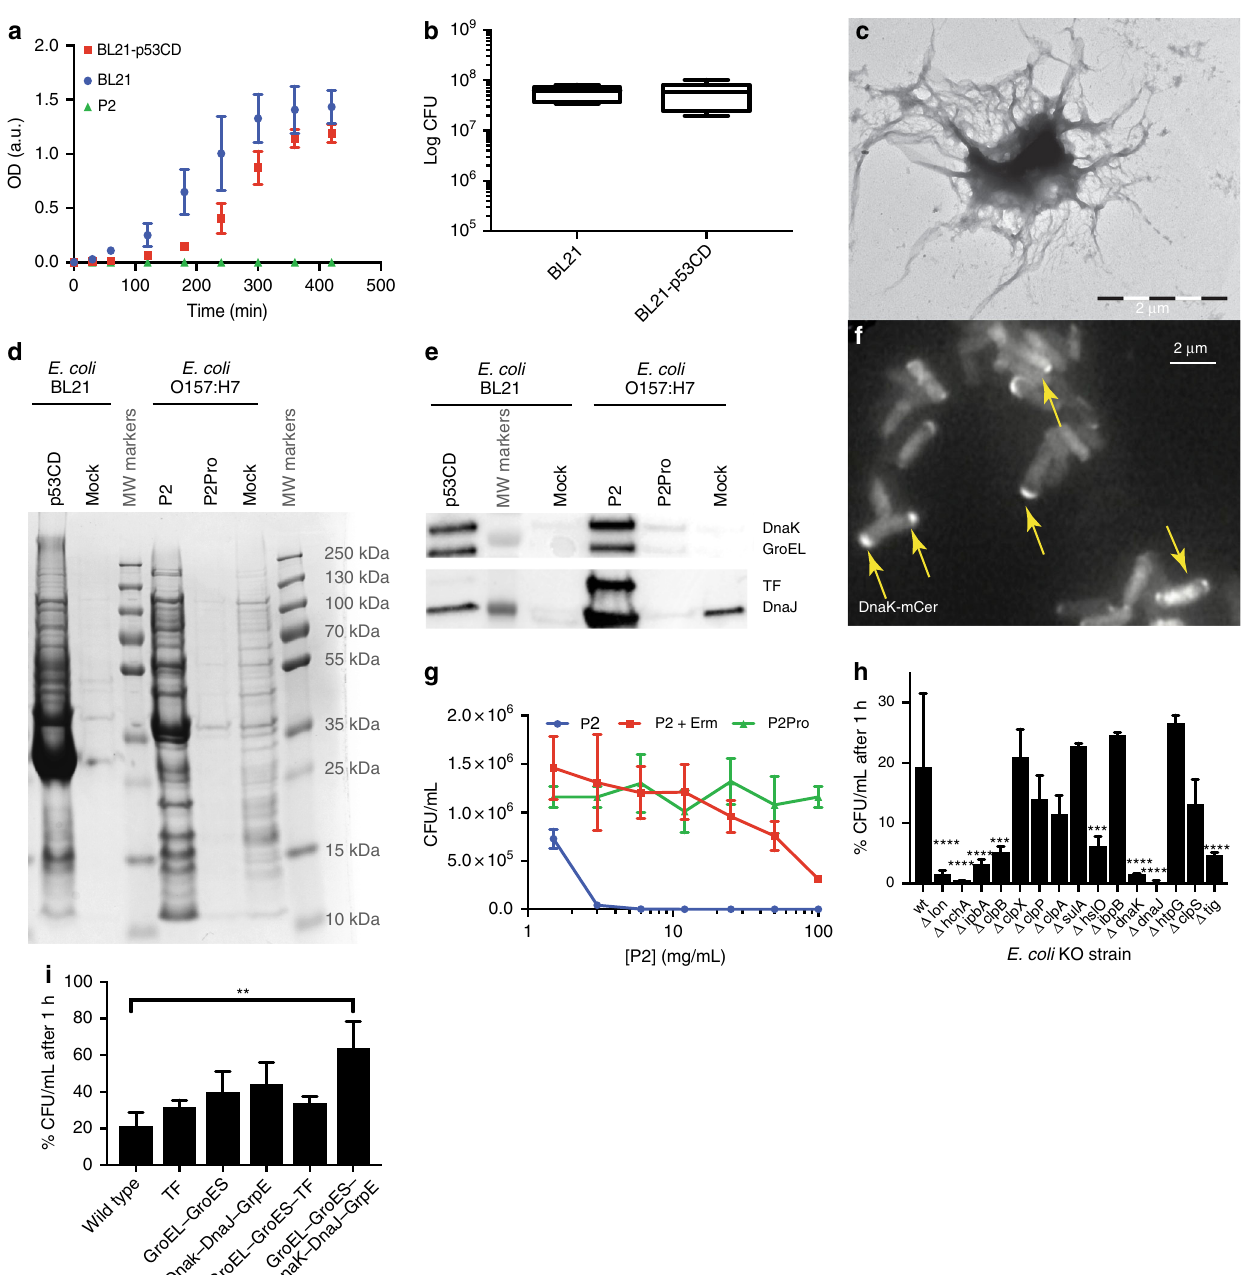
Fig. 3 Inclusion body formation and proteostatic collapse. a Growth curve of E . coli BL21-overexpressing p53CD (red) and control in the presence (green) or absence (blue) of P2 (average and SD of three replicates). p53CD bacterial growth in the presence of 0.4 mM IPTG. b Colony formation by E . coli BL21 p53CD-overexpressing bacteria. The bottom and top of the box are the fi rst and third quartiles, and the band inside the box represents the median. The whiskers are drawn using Tukey ’ s method and show the extreme values that fall within 1.5 times the interquartile range. c Transmission electron microscopy image of an inclusion body from P2-treated E . coli O157:H7 (uranyl acetate). d Representative Coomassie blue SDS-PAGE of inclusion bodies from E . coli BL21-overexpressing p53CD (lane 1), mock (lane 2), and E . coli O157:H7 treated with P2 (lane 4), P2Pro (lane 5), or DMSO (lane 6). Molecular- weight markers are shown in lanes 3 and 7. e Western blot for dnaK, groEL, tig, and dnaJ of the same samples than that in d . f Fluorescence microscopy image of E . coli cells stably expressing a fl uorescent fusion of DnaK (mCer) treated with P2 at MIC concentration. g Growth inhibition of cells treated with P2 with/without erythromycin (Erm, 100 μ g/mL, average and SD of three replicates). h Percent of colony-forming units after treating bacterial KO strains (KEIO) for 1 h with P2 at its MIC concentration. i Percent of colony-forming units of chaperone-overexpressing E . coli strains treated by P2 peptide at MIC concentration for 1 h. Signi fi cant differences from the WT are calculated using ordinary one-way ANOVA and Dunnett ’ s multiple-comparison test. Statistical signi fi cance is indicated as follows: ** P ≤ 0.01, *** P ≤ 0.001, **** P ≤